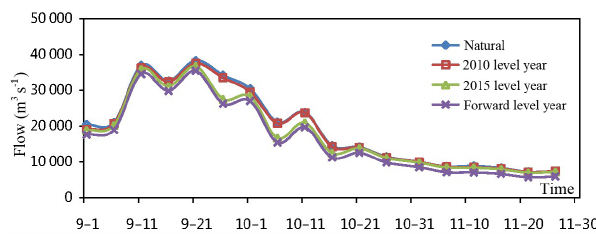
Figure 7. Process of Yichang hydrological station from September to November in slightly dry year